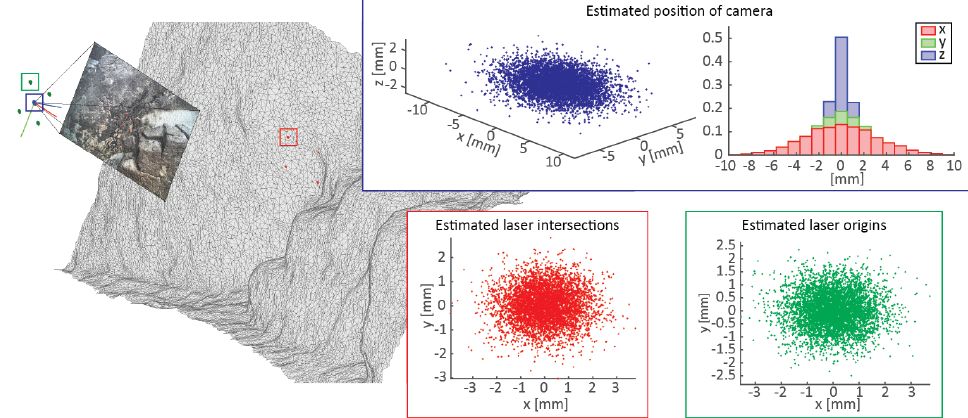
Figure 18. Intermediate results of a scale estimation